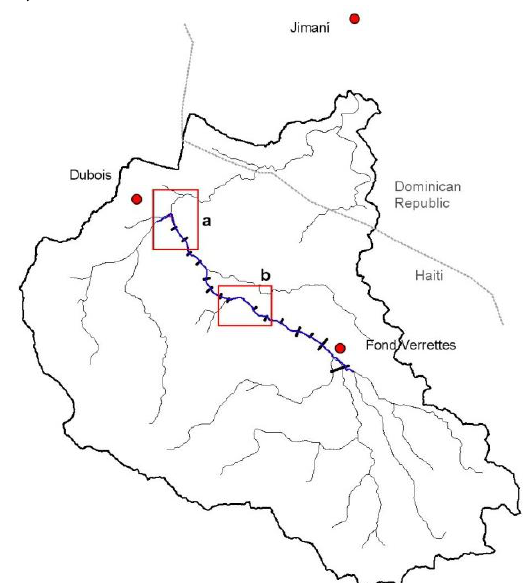
and 20% (lower basin) to the Dominican Republic. Stream- channel slopes range from 17% (upper basin) to 2% (lower basin).